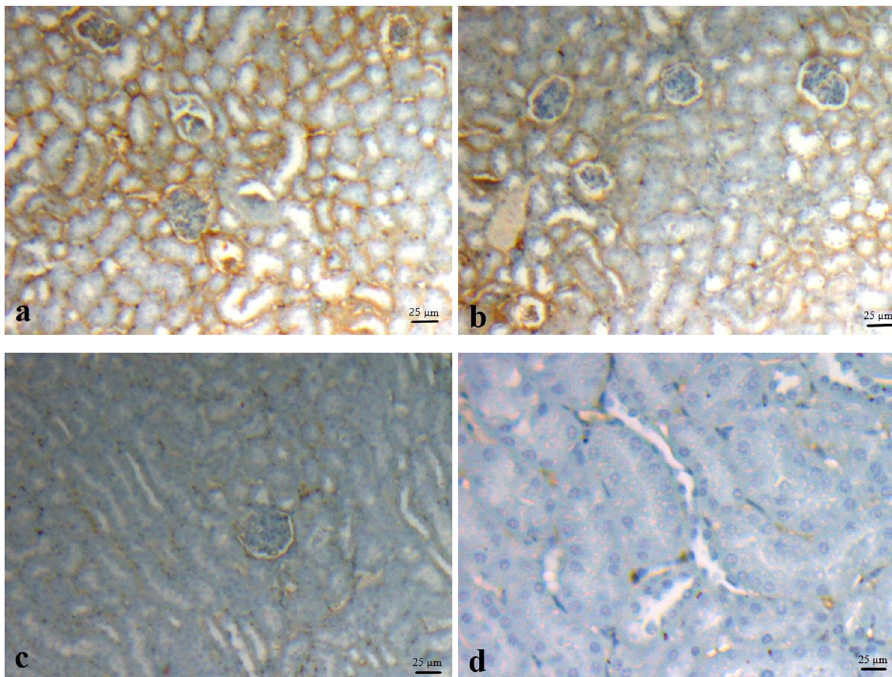
Figure 2: In the kidney tissue, bcl - 2 immunoreactivity was observed in the tubule cells, sinusoidal epithelium, and glomerular cells in all the groups. ( a ) Dense immunoreactivity in the cortex region of the kidney tissue obtained from the control group. ( b ) Moderate immuno - reactivity in the kidney cortex area in 5mgkg − 1 acetamiprid group. ( c ) Poor immunoreactivity in the kidney cortex – medulla area in 10mgkg − 1